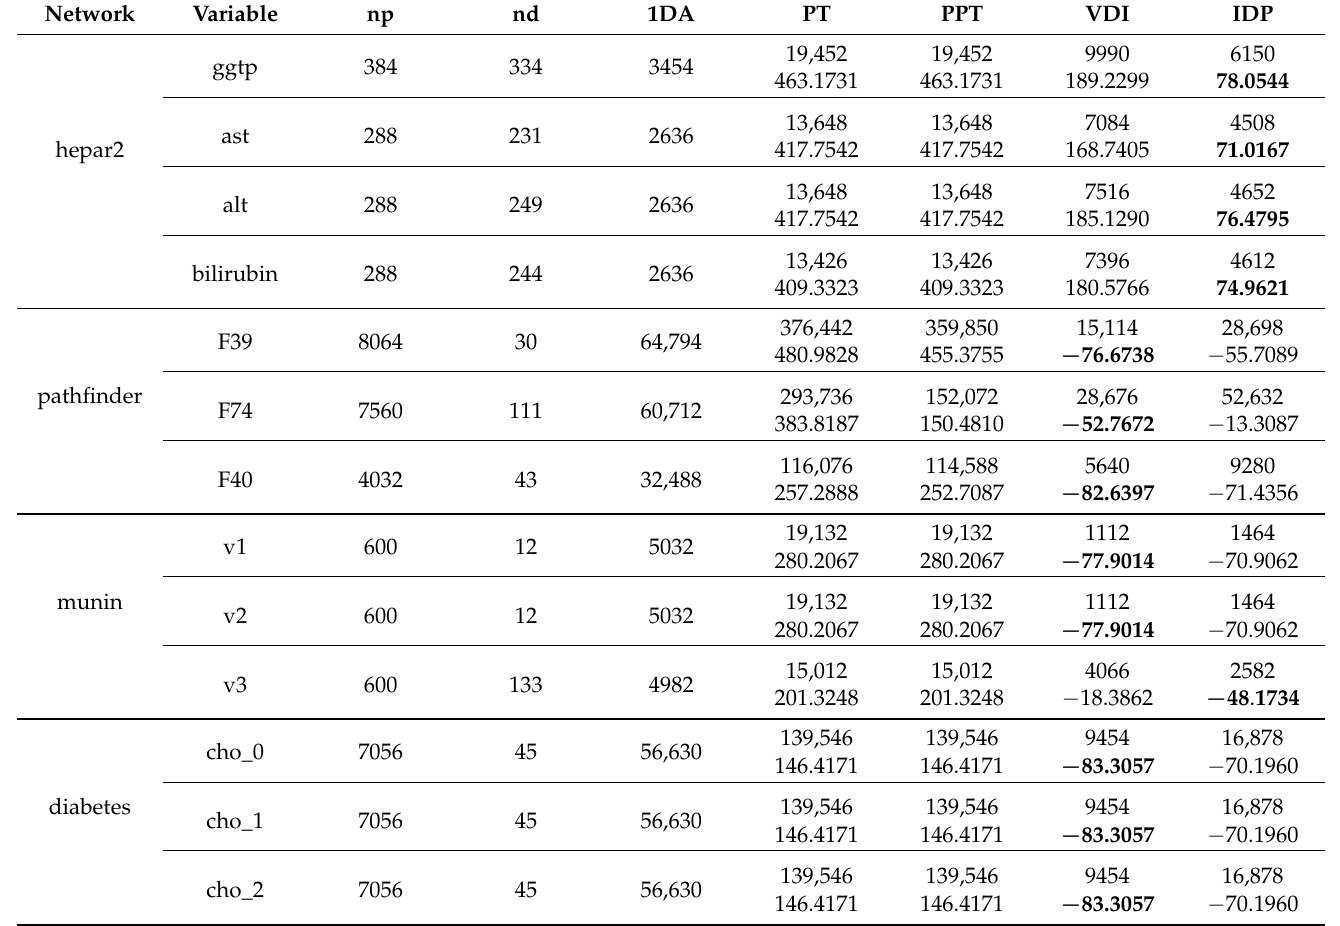
Table 7. Local memory size analysis. Numbers in bold typeface denotes the best saving percentages (or with the smallest increase